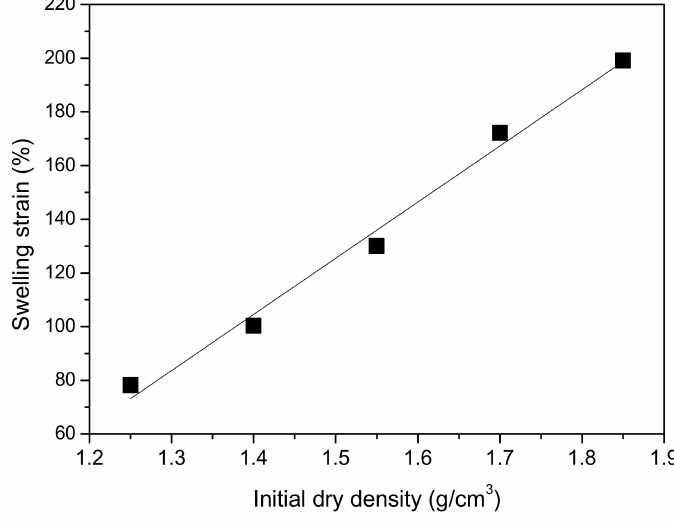
Figure 8. Relationship between final unloaded swelling strain and corresponding initial dry density of MB